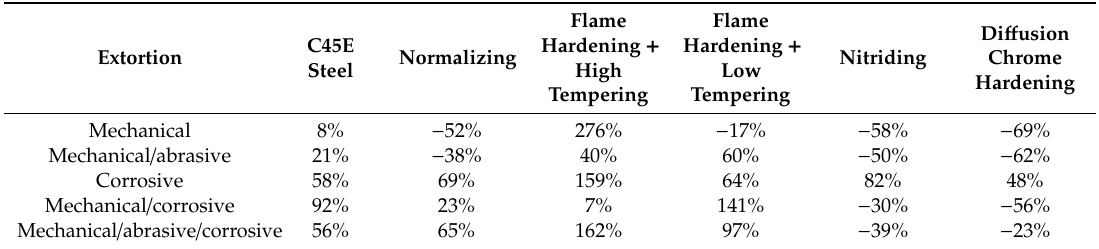
Table 10. Percentage changes in the Rv parameter depending on the tested variants of the surface layer.